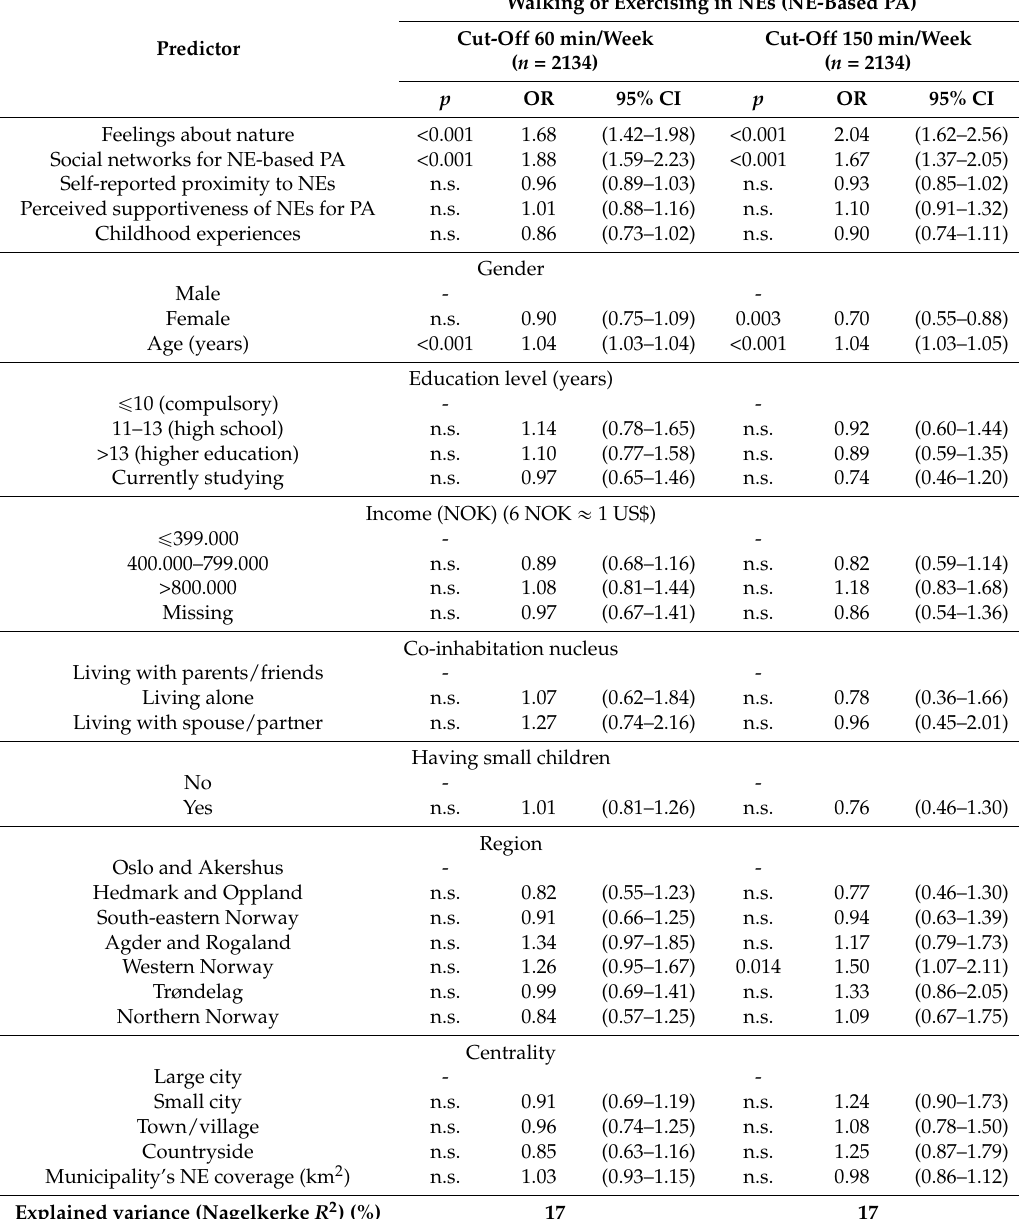
Table 3. Logistic regression of self-reported proximity to NEs, perceived supportiveness of natural environment for physical activity and childhood experiences of nature predicting different levels of physical activity in Norwegian adults, after controlling for socio-demographic characteristics and possible